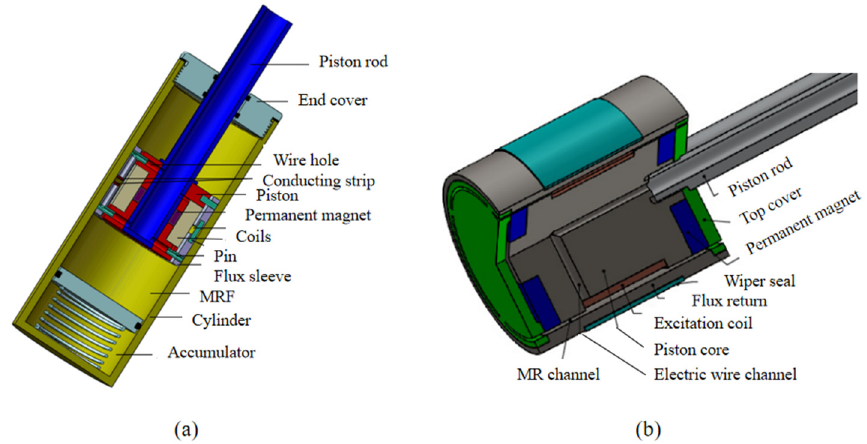
Figure 15. Hybrid MRD with both coils and permanent magnets: ( a ) MRD with one permanent magnet [88]; ( b ) MRD with two permanent magnets [91].